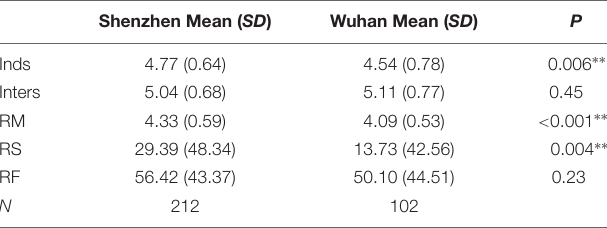
TABLE 1 | Descriptive statistics of independent and dependent variables by two